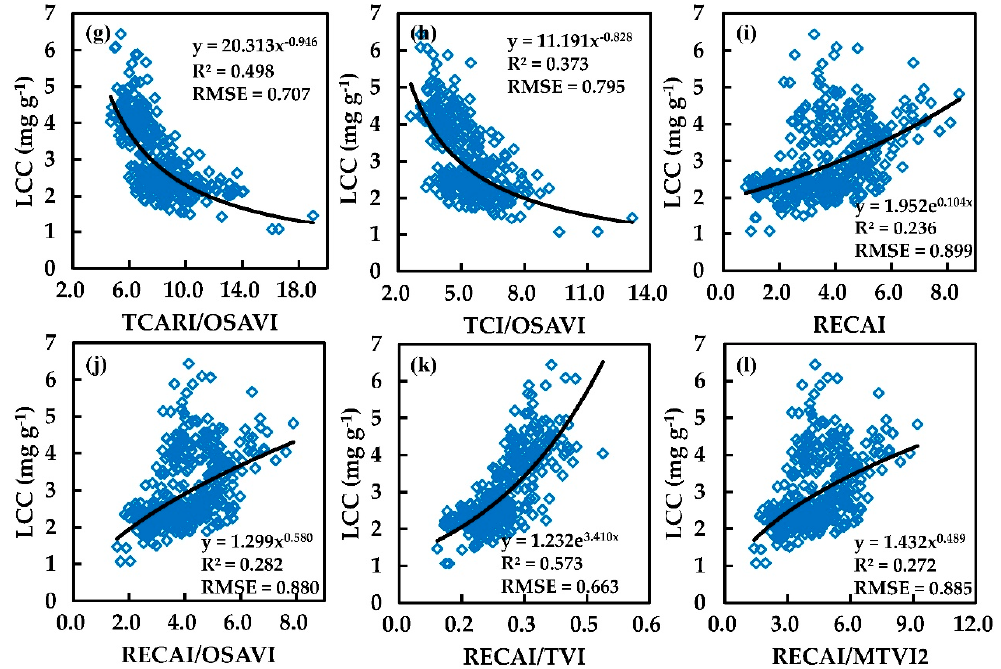
Figure 3. ( a – l ) The scatterplots between measured LCC versus CI green , CI red-edge , MTCI, R-M, DCNI I, MCARI / OSAVI, TCARI / OSAVI, TCI / OSAVI, RECAI, RECAI / OSAVI, RECAI / TVI, and RECAI / MTVI2 for the 2002 + 2010 combined calibration dataset ( n = 365),